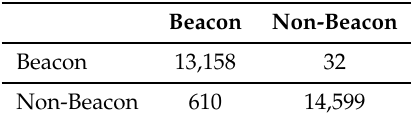
Table 2. LiDAR training confusion matrix.